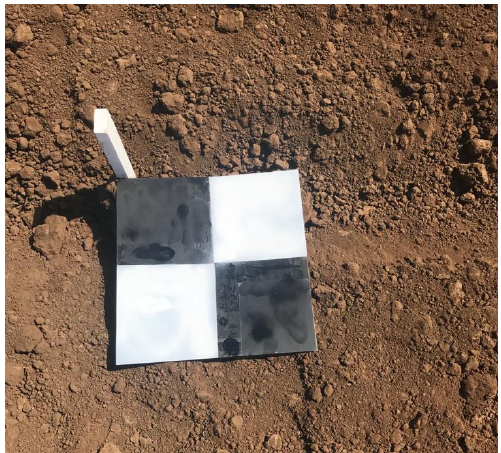
Figure 3. Location of the ground control points (GCP).